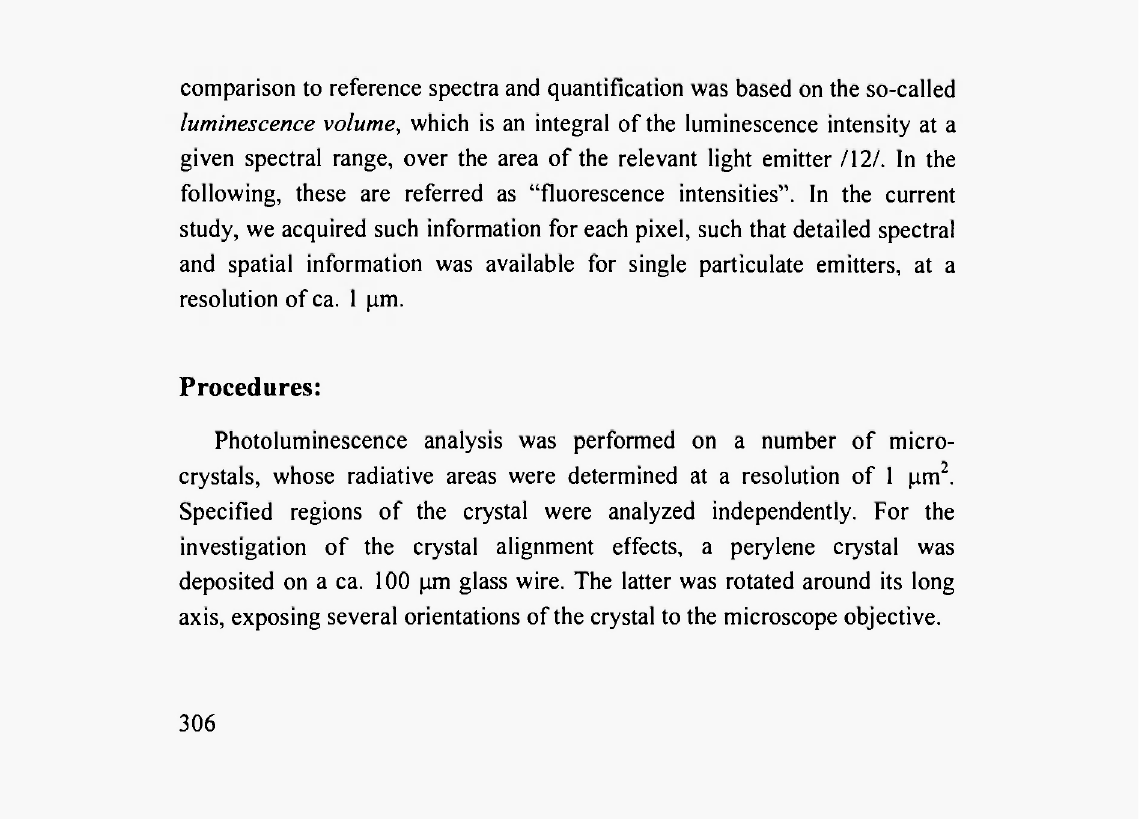
Fig. 1: Experimental setup for microscopic imaging fluorescence